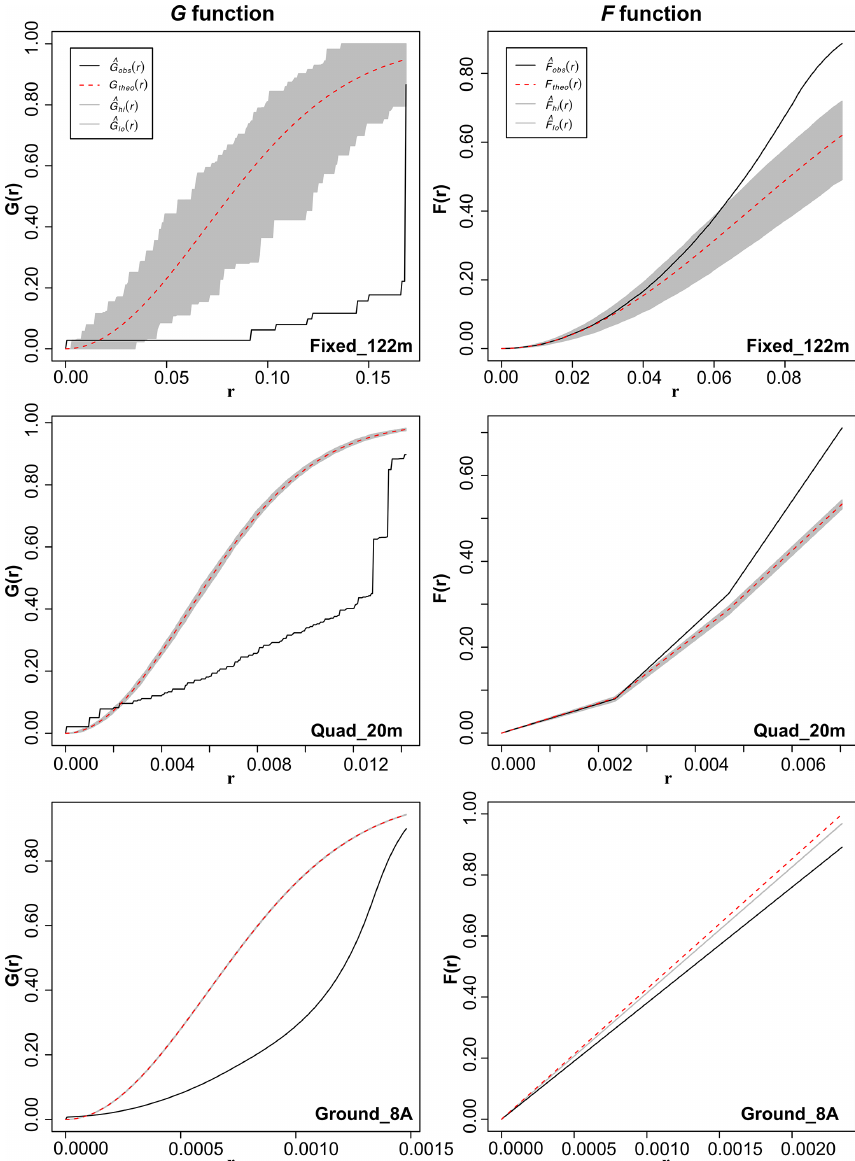
Figure 8. Results of the G function and F function analysis for the Fixed_122m, Quad_20m, and Ground_8A datasets.